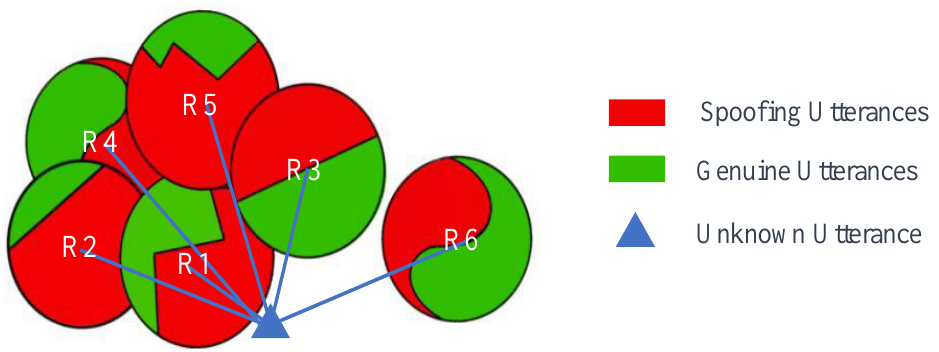
Figure 4. Illustrative example of the proposed spoofing countermeasure based on local classification subproblems .